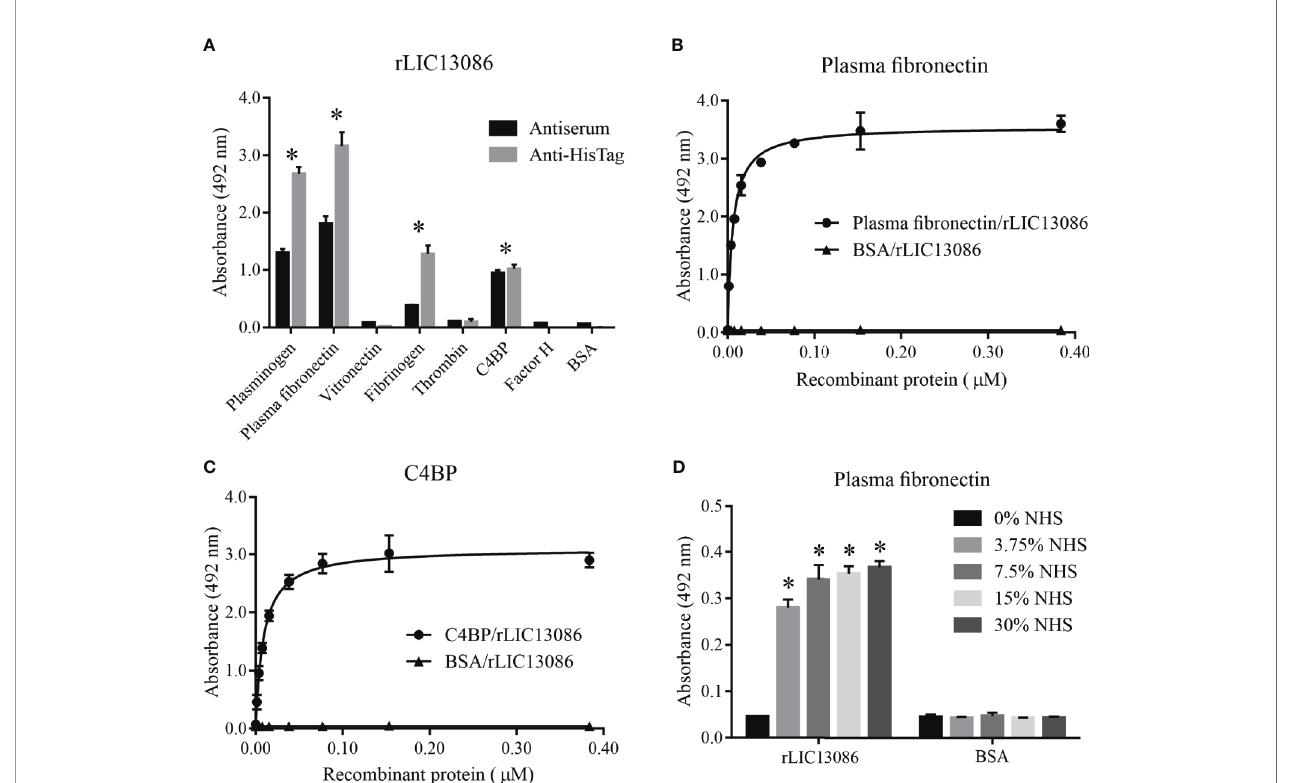
FIGURE 5 | Interaction of rLIC13086 with plasma components. (A) Plasma components were coated onto ELISA plates (1 m g) and incubated with rLIC13086 (1 m g) for 2 h at 37°C. Detection was performed with HRP-conjugated anti-HisTag mAb (1:10,000), or anti-rLIC13086 antiserum (1:5,000) and secondary HRP-conjugated anti-mouse IgG (1:5,000). Coated plasma fi bronectin (B) and C4BP (C) were incubated with different concentrations of rLIC13086 (0 – 0.5 m M) for 2 h at 37°C and detected with HRP-conjugated anti-HisTag mAb (1:10,000). (D) rLIC13086 was immobilized and incubated with increasing concentrations of NHS. The interaction was assessed by the addition of rabbit anti-human plasma fi bronectin (1:10,000) followed by HRP-conjugated anti-rabbit IgG (1:10,000). BSA was used as negative control. The bars represent the means of three different experiments in triplicates with the corresponding standard deviation. * Indicates signi fi cant difference calculated by Student t- test with p-values <